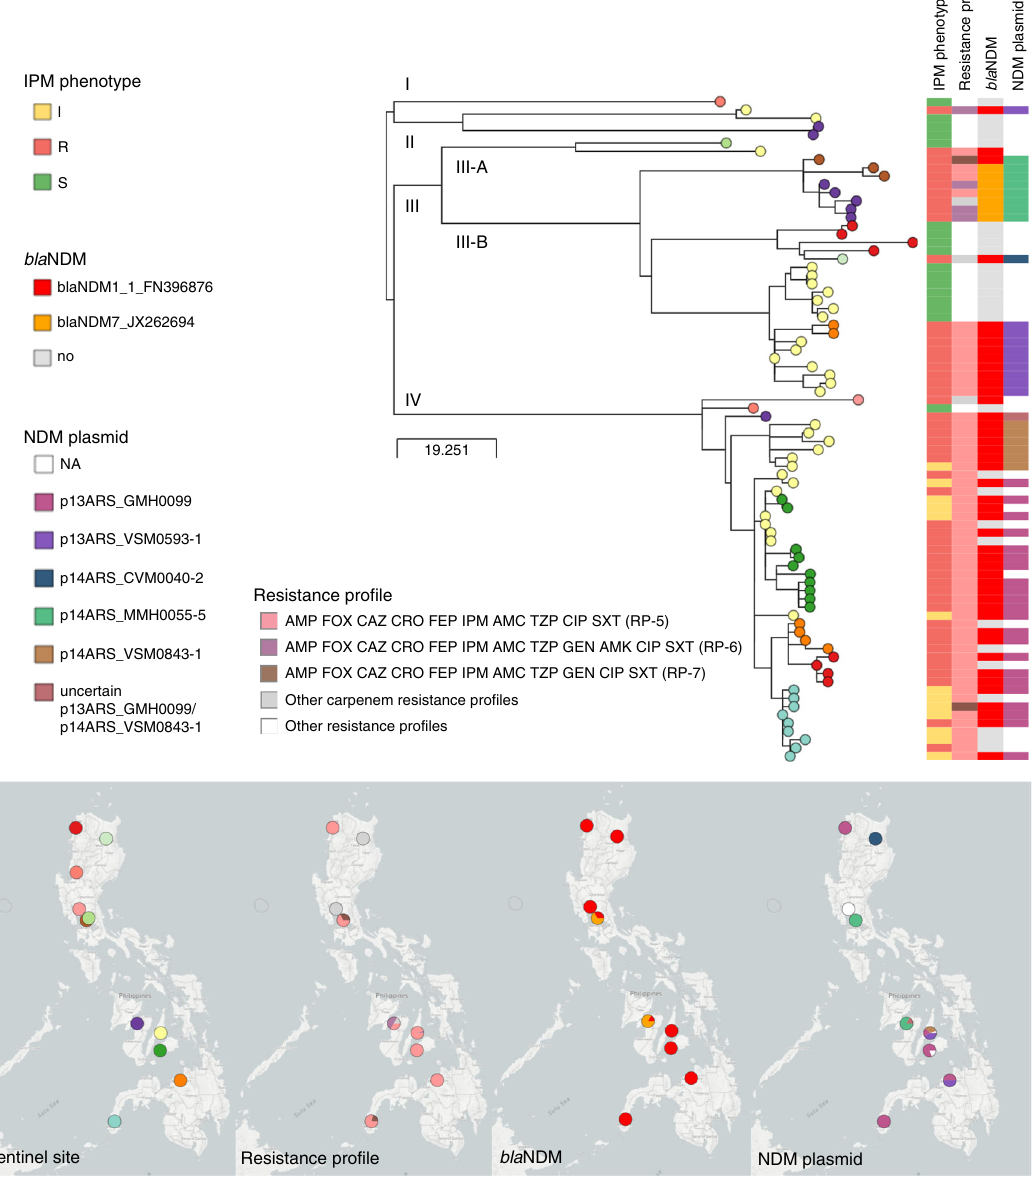
Fig. 5 WGS dissects the circulation of K. pneumoniae ST147 in the Philippines. Phylogenetic tree and linked epidemiological and genotypic data of 80 ST147 genomes. The imipenem (IPM) phenotype was either resistant (R), intermediate (I) or susceptible (S). The three-letter antibiotic codes in the resistance pro fi les are as in Table 1. This interactive view is available at https://microreact.org/project/ARSP_KPN_ST147_2013-14/4c33ace7. The maximum-likelihood tree was inferred from 809 SNP positions identi fi ed by mapping the genomes to reference MS6671 (LN824133.1 [https://www.ncbi. nlm.nih.gov/nuccore/LN824133.1]) and masking regions corresponding to mobile genetic elements and recombination. The scale bar shows the number of SNPs per variable site. The distribution of plasmids with NDM genes was inferred by mapping the short reads of the genomes to the complete plasmid sequences, and a match was counted when the reads covered at least 95% of the sequence length with at least 5x depth of coverage. The full data are available at